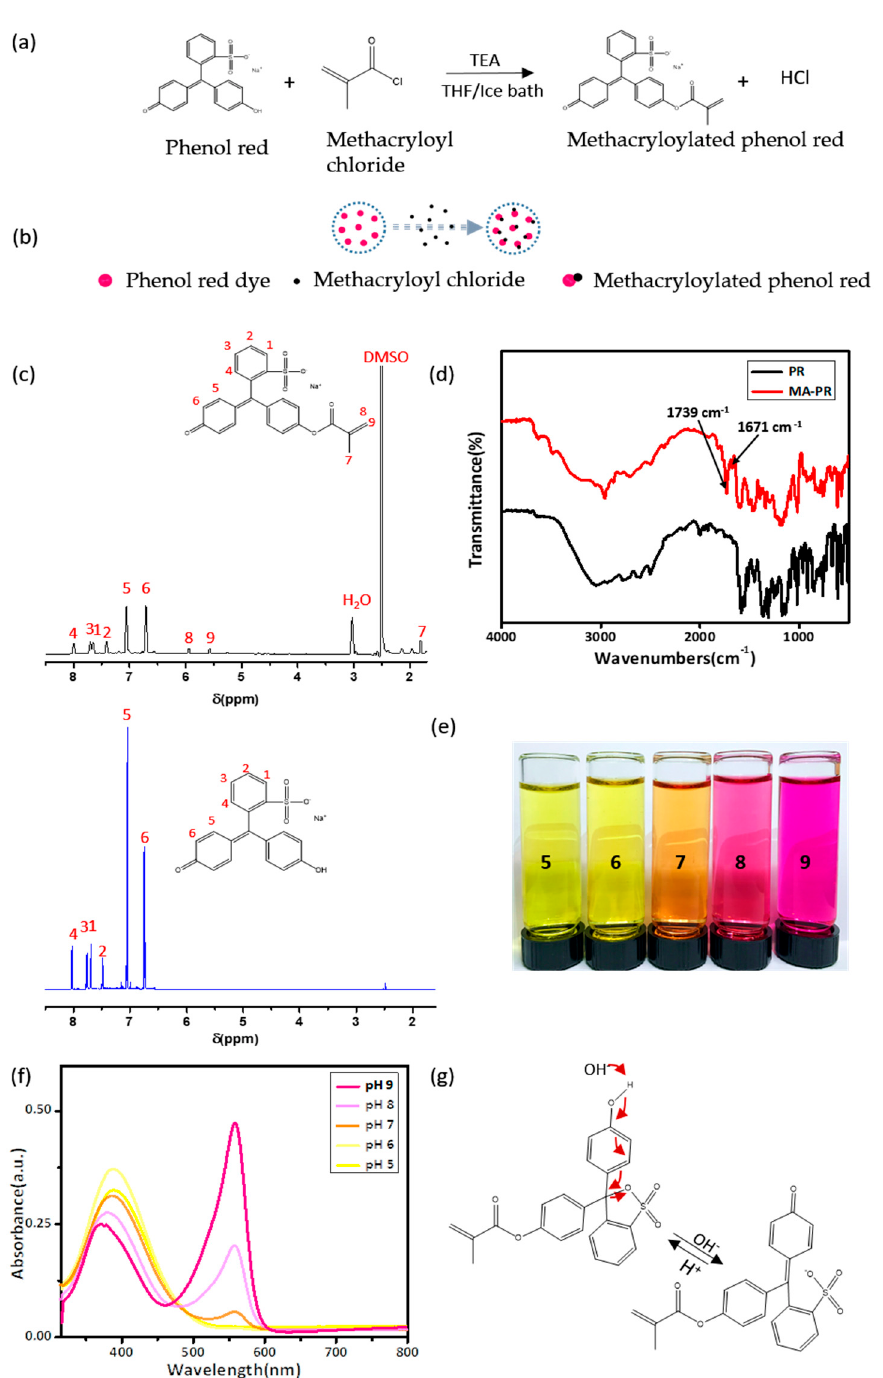
Figure 1. Synthesis and characterization of MA-PR. ( a ) Reaction scheme for the preparation of MA-PR; ( b ) schematic diagram for the synthesis of MA-PR; ( c ) 1 H NMR spectra of PR (blue) and MA-PR (black); ( d ) FTIR spectra of PR and MA-PR; ( e ) a photographic image that shows the colorimetric transition of MA-PR in buffer solutions with pH values from 5 to 9 (from left to right); ( f ) UV-VIS absorption spectra of MA-PR in buffer solutions with pH values from 5 to 9 and ( g ) a schematic drawing that represents the resonance transition in the MA-PR molecule in acidic (left) and basic (right) environments.